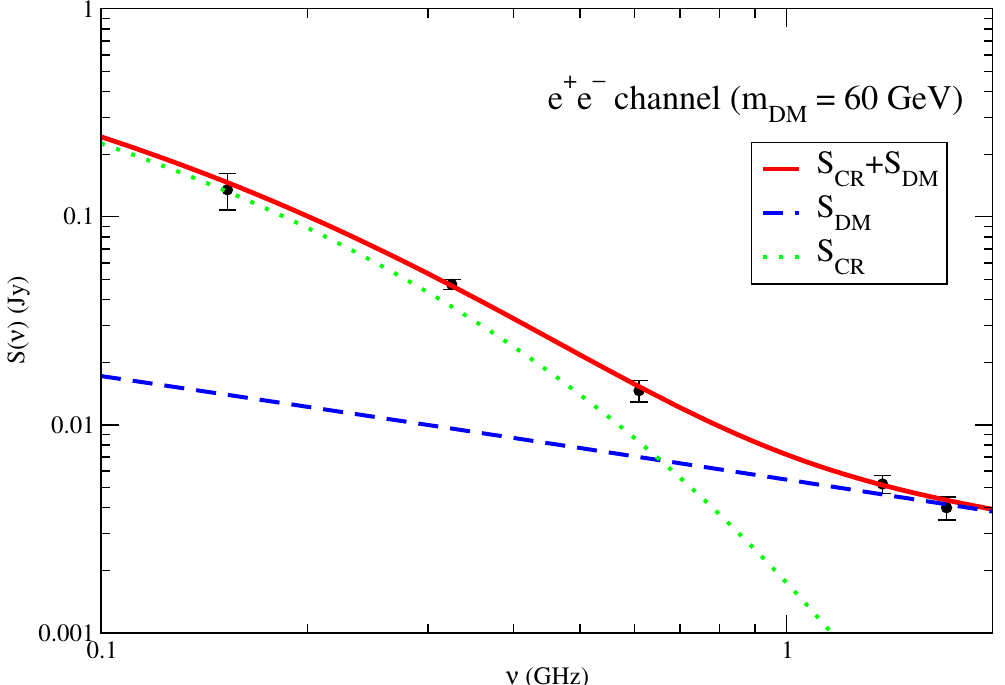
Figure 3. The best-fit dark matter scenario for the Abell 697 cluster radio data ( m DM = 60 GeV via the e + e − channel) [38]. The red solid line, green dotted line, and blue dashed line represent the total predicted radio flux S ( ν ) , the cosmic-ray contribution (Fermi-II model), and the dark matter contribution, respectively. The data with error bars were extracted from